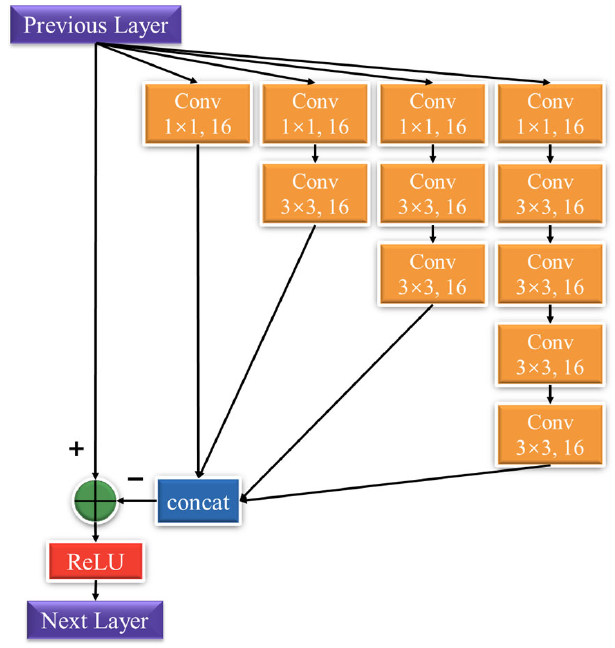
Figure 2. The structure of MFE.